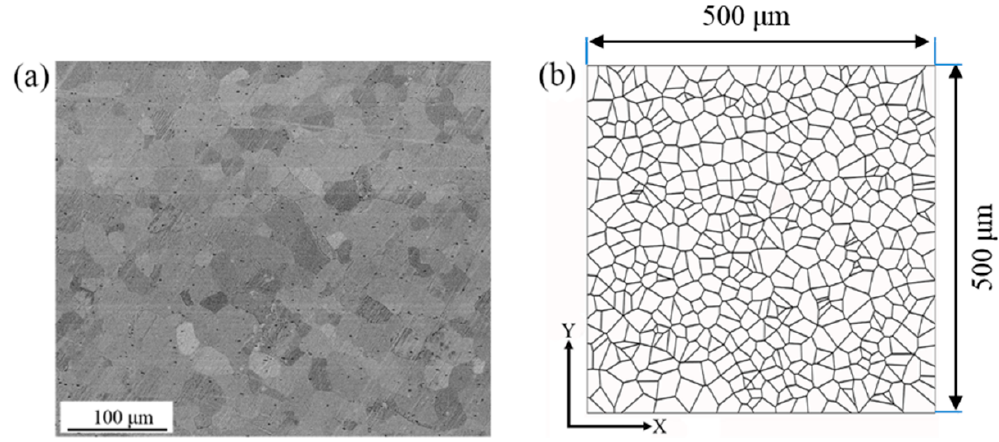
Figure 3. ( a ) Cross-sectional scanning electron microscope morphology of as-received NiTi SMA and ( b ) voronoi tessellation generated using NEPER.